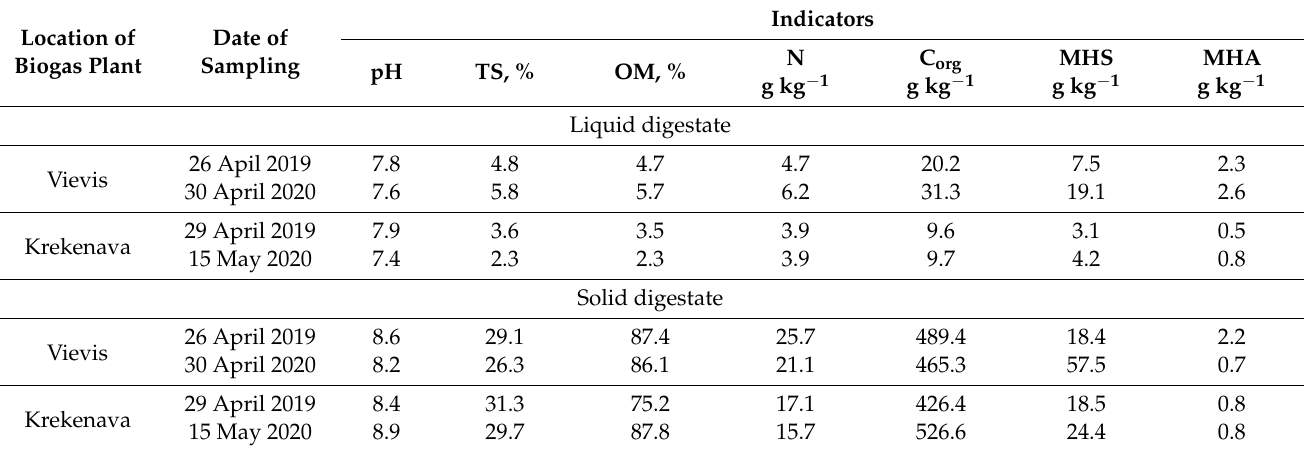
Table 1. Chemical composition of the digestate used for fertilization, 2019 , 2020